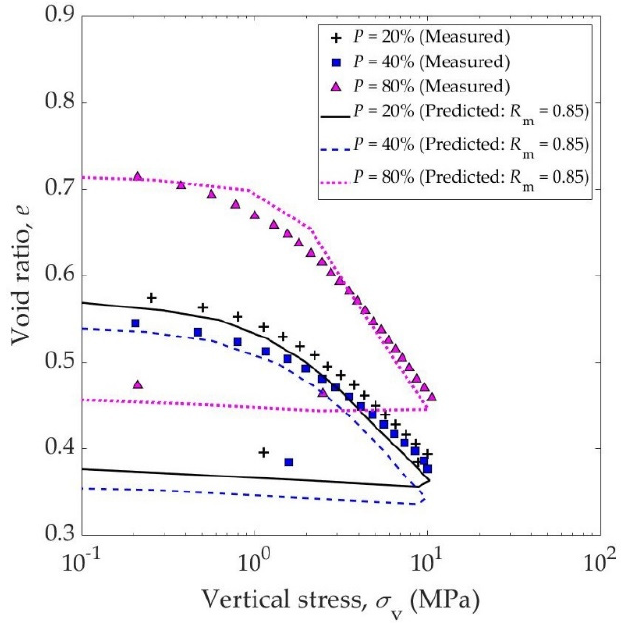
Figure 5. Compression characteristics of sand and gravel components of D-G-S.